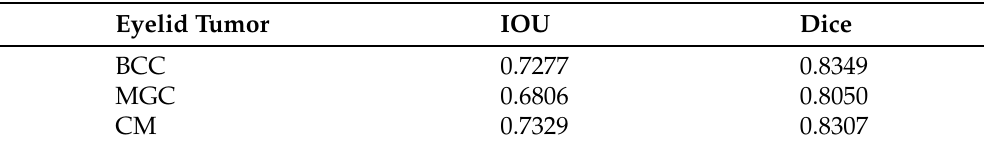
Figure 6. Visualization of results: The segmentation results can provide the doctor with aid in diagnosing what kind of tumor the pathology image contains and where the tumor is located. Table 7. Overall average segmentation